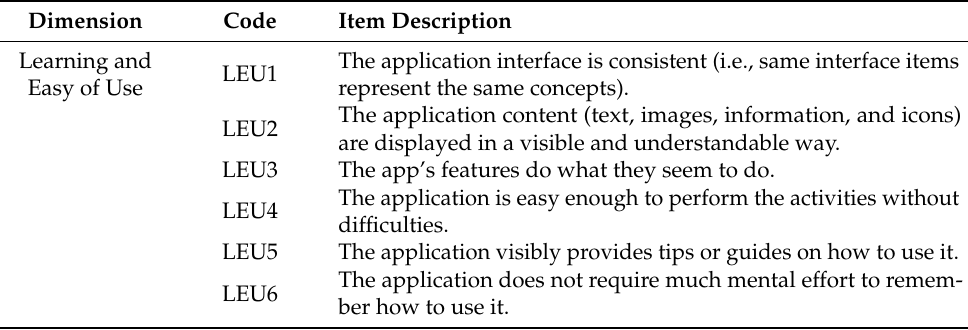
Table 9. The Learning and Easy of Use dimension and its